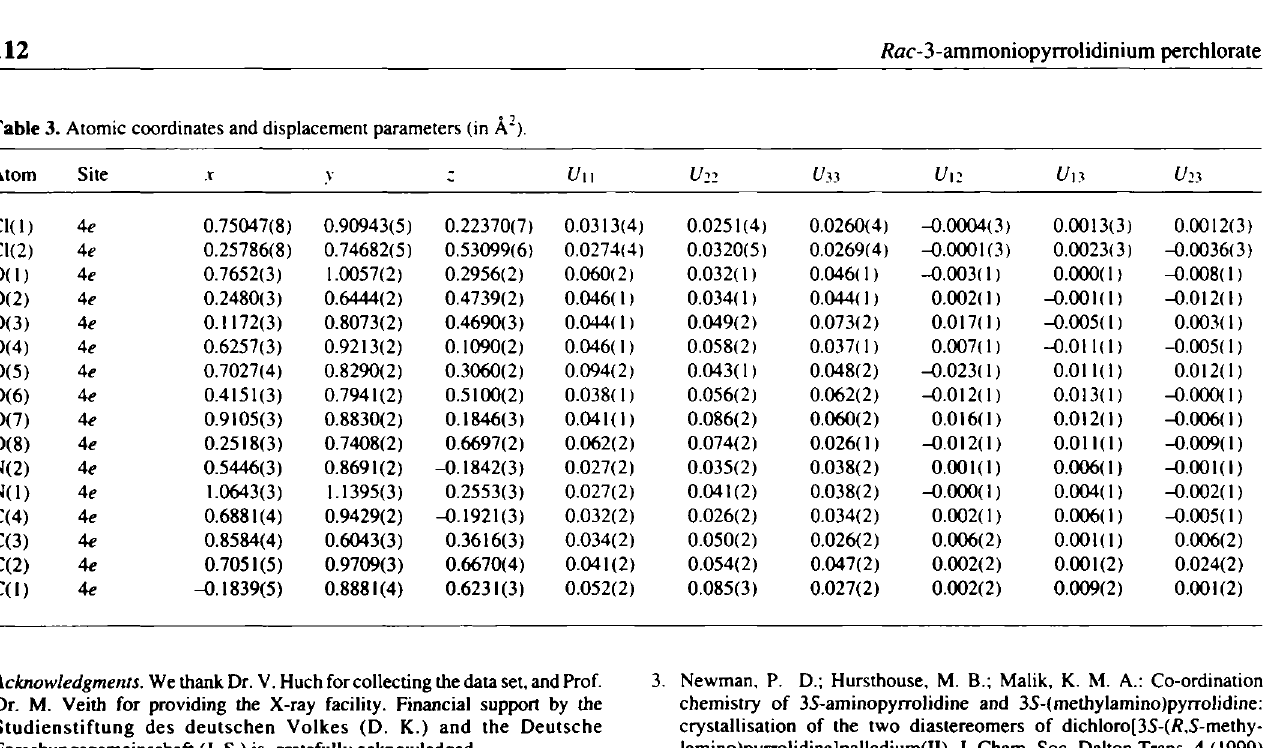
Table 3. Atomic coordinates and displacement parameters (in